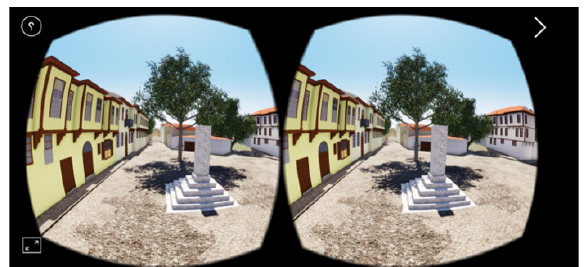
Figure 5. 3D visualization by using VR mobile applications of